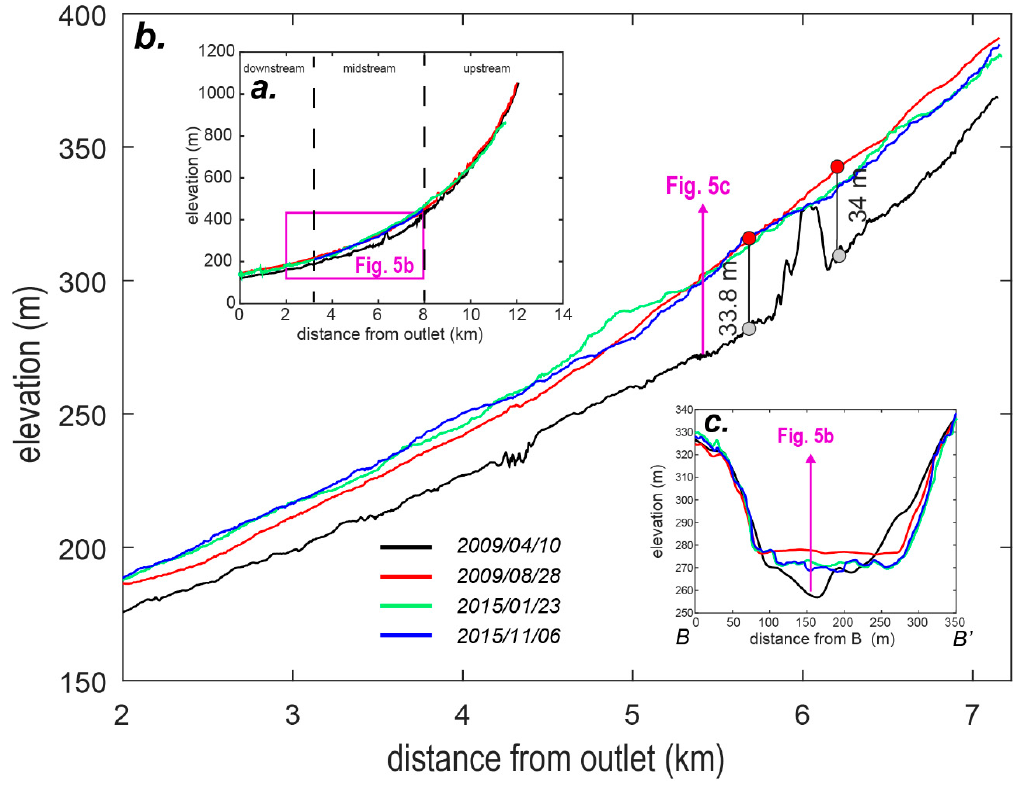
Figure 5. ( a ) Longitudinal profile of the Laishe River. ( b ) Longitudinal profile of the Laishe River midstream. Location of outlet marked in Figure 3. ( c ) Cross section of the Laishe River in profile B-B’. Location of profile B-B’ marked in Figure 4c. Colored lines denote different periods.